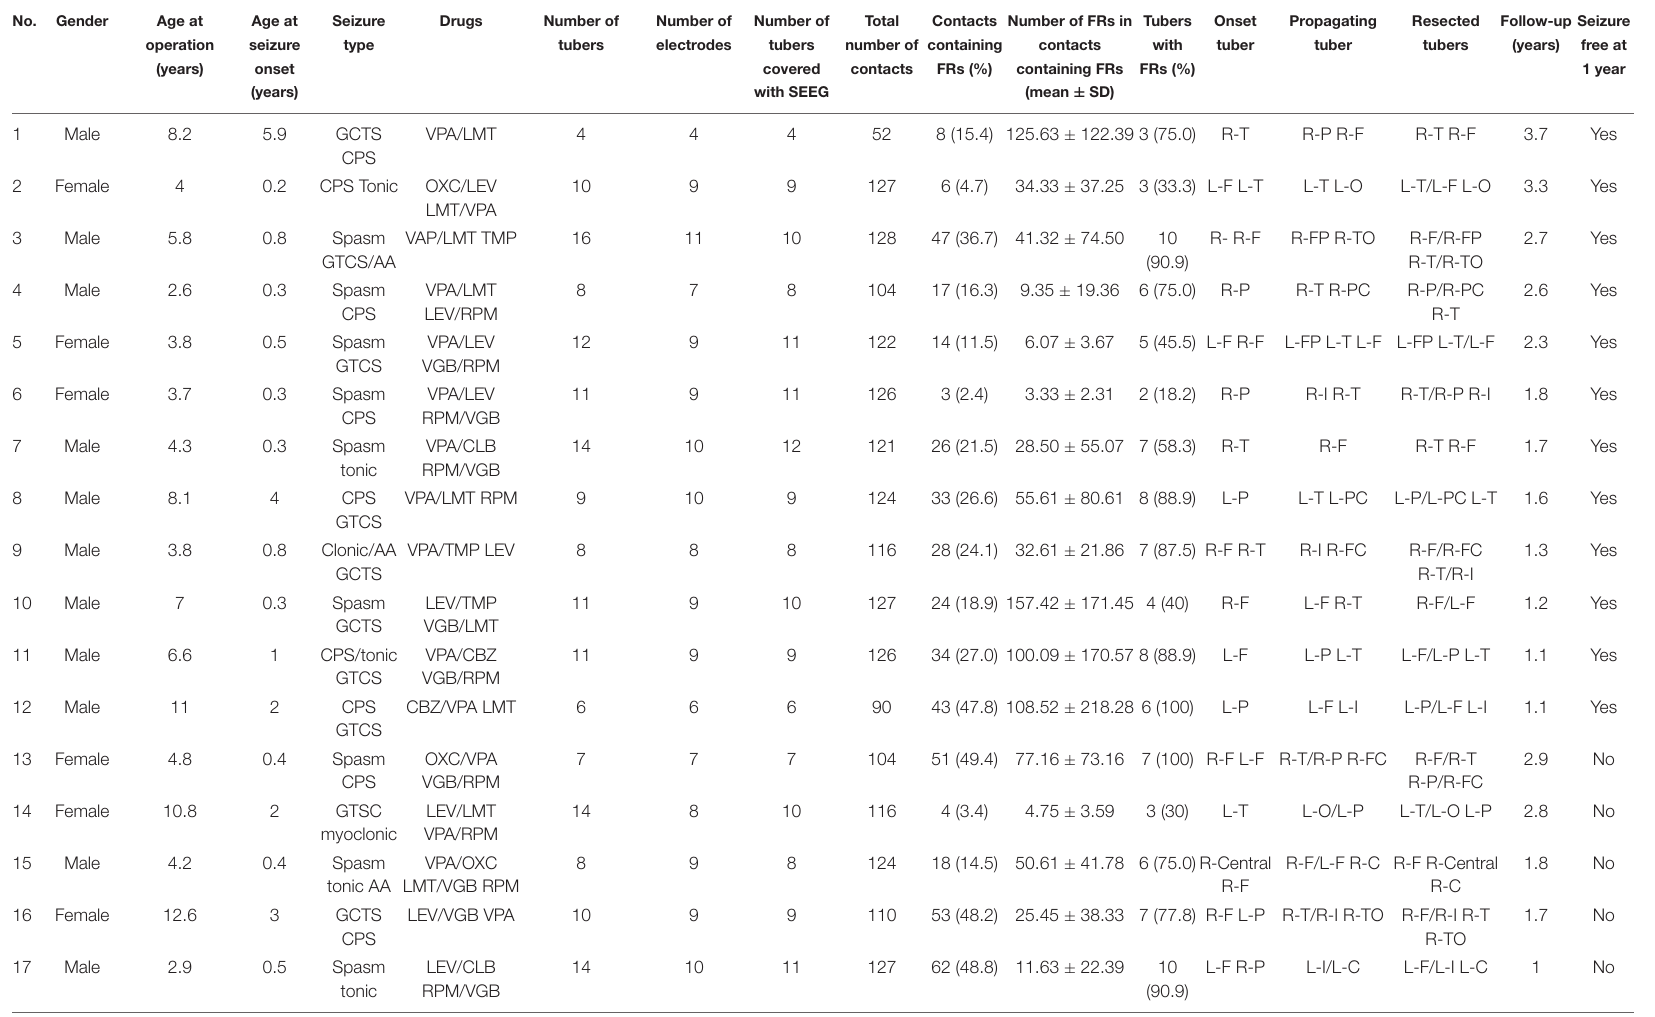
TABLE 1 | Patients’ clinical and demographic characteristics and FR